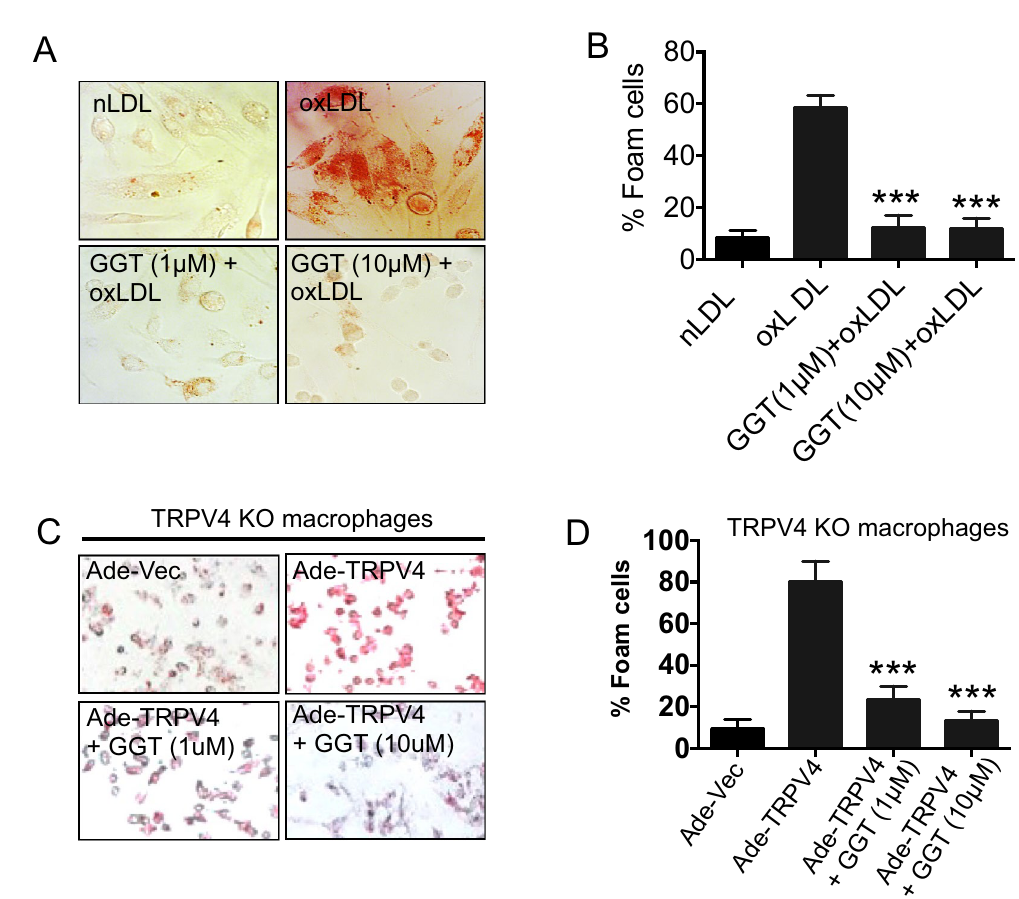
Figure 2. Inhibition of TRPV4 by ginkgetin abrogates oxLDL-induced macrophage foam cell formation. ( A ) Thioglycolate-induced murine peritoneal macrophages were treated overnight with 50 µg/ml oxLDL, followed by a 3 h preincubation with vehicle or 1 or 10 µM ginkgetin. Cells were treated with 50 µg/mL native LDL (nLDL) as control. Original magnification: 40x. ( B ) Quantification of the results shown in ( A ). n = 500 cells/ condition. Student’s t -test; *** p < 0.001. Data represent ± SEM. ( C ) TRPV4 KO RPMs were transduced with either Ade-Vec or Ade-TRPV4, and were untreated or treated with GGT in the presence of oxLDL for 16 h on day 5 of transduction for macrophage foam cell formation. ( D ) Quantification of the results shown in C. n = 100 cells/condition. Student’s t -test; *** p <